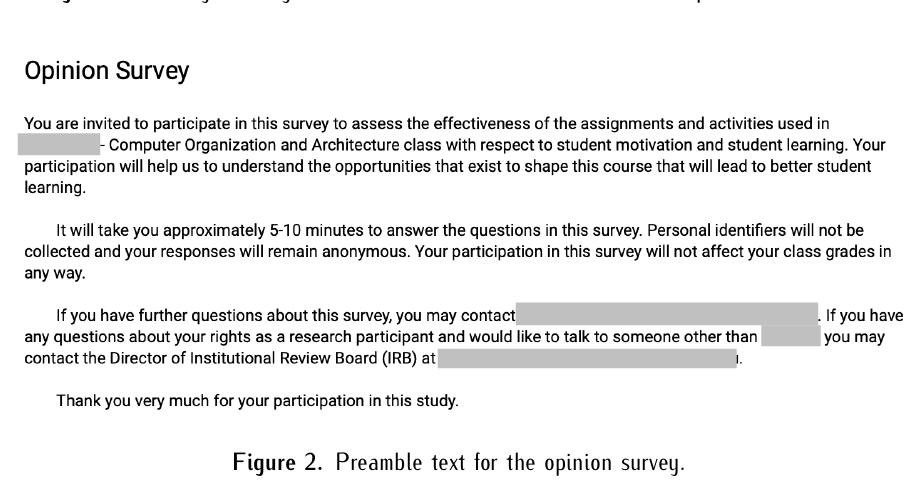
Figure 2. Preamble text for the opinion